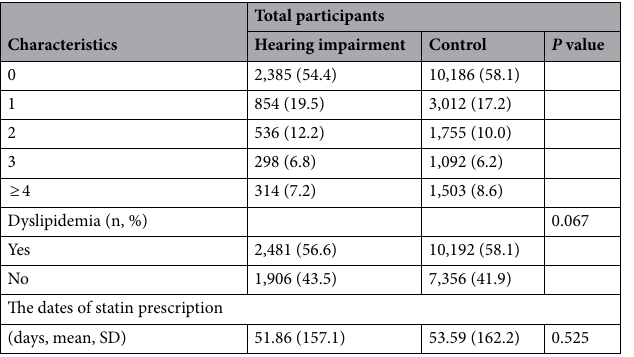
Table 1. General characteristics of participants. Abbreviations: CCI, Charlson comorbidity index; SD, standard deviation. *Chi-square test. Significance at P < 0.05. † Independent t test. Significance at P < 0.05. ‡ Obesity (BMI, body mass index, kg/m 2 ) was categorized as < 18.5 (underweight), ≥ 18.5 to < 23 (normal), ≥ 23 to < 25 (overweight), ≥ 25 to < 30 (obese I), and ≥ 30 (obese II). § CCI scores were calculated without dementia.